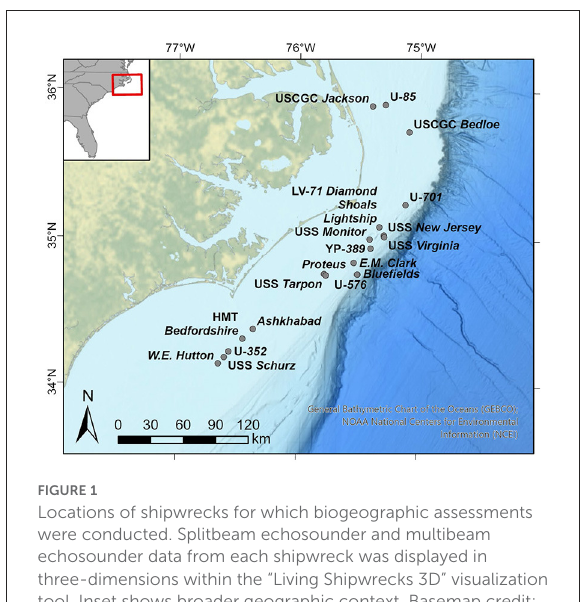
FIGURE1 Locations of shipwrecks for which biogeographic assessments were conducted. Splitbeam echosounder and multibeam echosounder data from each shipwreck was displayed in three-dimensions within the “Living Shipwrecks 3D” visualization tool. Inset shows broader geographic context. Basemap credit: General Bathymetric Chart of the Oceans, NOAA National Centers for Environmental